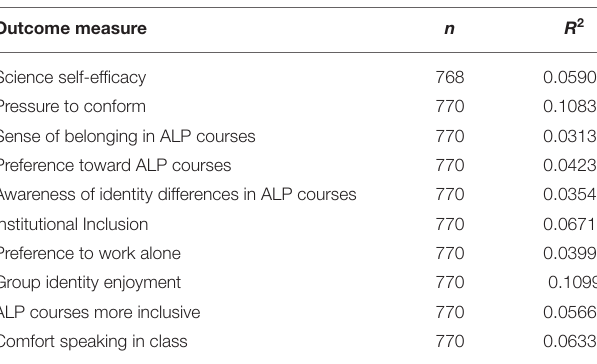
TABLE 4 | The total amount of variance explained by identity facet predictor variables within our best fit piecewise path